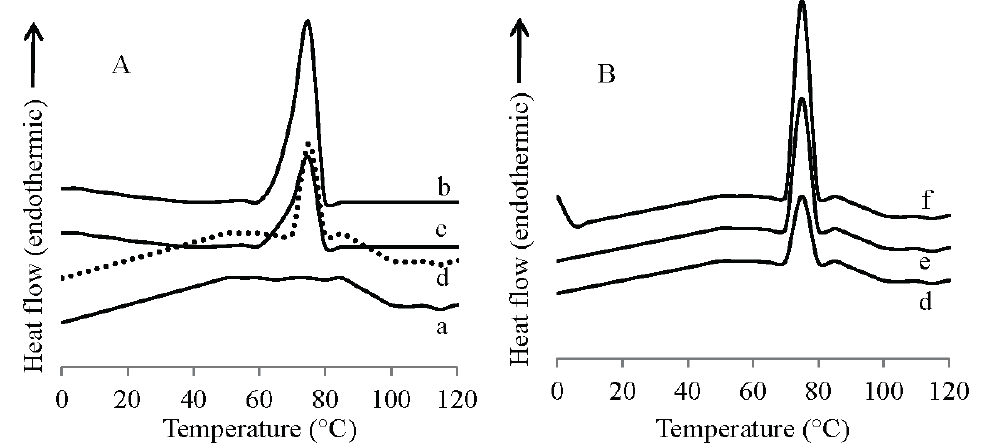
Figure 4. DSC thermogram of unloaded complex coacervate (a), m-INN (b), 1:1:1 physical mixture of CMSP: gelatine: m-INN (c), 30 (d), 45 (e) and 56% w / w (f) m-INN-loaded complex coacervate. ( A ) represents thermograms of unloaded coacervate (a), m-INN (b), 1:1:1 physical mixture of CMSP: gelatine: m-INN (c) and 30% w / w (d) loaded coacervate. ( B ) indicates influence of different drug loading in the intensity of crystalline